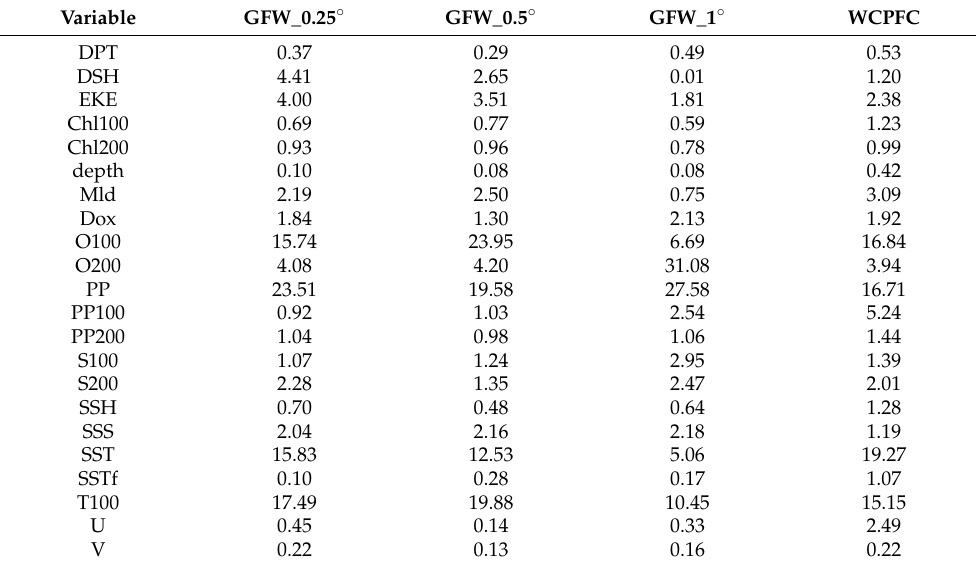
Table 2. The average contributions of the environmental variables to the Maxent